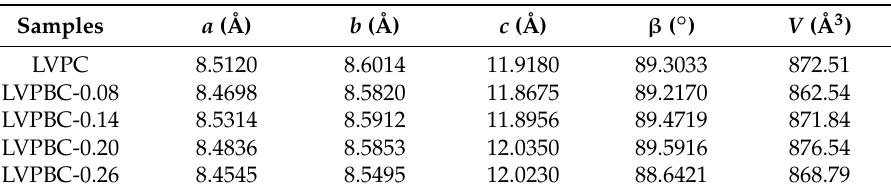
Table 1. The lattice parameters of the Li 3 V 2 (PO 4 ) 3 − x Br x /carbon (LVPBC) and pristine Li 3 V 2 (PO 4 ) 3 / carbon (LVPC) composites.